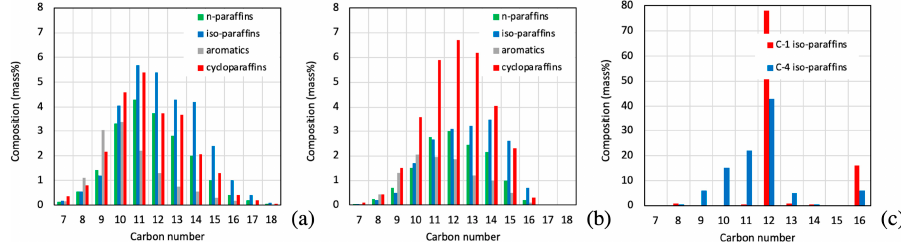
Figure 1. Hydrocarbon distribution plots of selected Category A and Category C jet fuels: ( a ) A2 or Jet A, ( b ) A3 or JP5, and ( c ) C1 and C4. Data extracted from Table 1. Main thermophysical properties of selected Category A and C fuels [62].